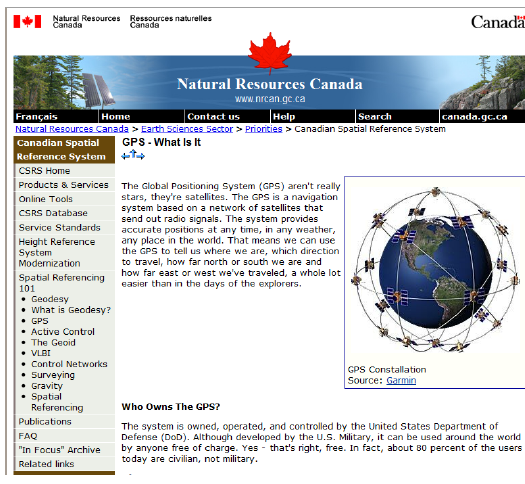
Figure 4: NRC – Tutorial on Spatial Referencing http://www.geod.nrcan.gc.ca/edu/geod/gps/gps0204_e.php